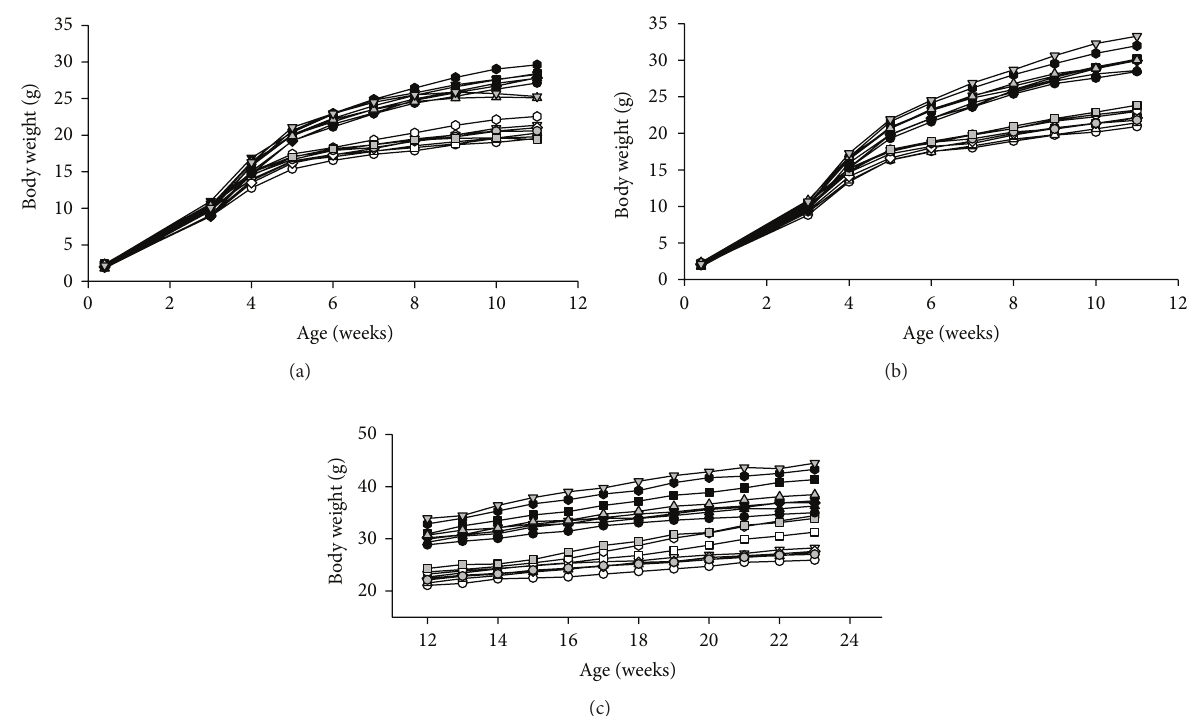
Figure 5: Body weight development (in gram) of female and male mice of all treatment groups is illustrated for (a) Min/+ and (b) wild-type mice from age 3-4 days to 11 weeks, and for (c) wild-type mice from age 12 to 23 weeks. The open white symbols are for untreated female mice; 10+10+10 ( I ), 45+10+10 ( △ ), 10+45+10 ( 󳶚 ), 45+45+10 ( ◻ ), 10+10+45 ( ◊ ), 45+45+45 (open hexagon), and the same filled black symbols are for untreated male mice. The PhIP-treated groups are marked with grey symbols; 45+45+10 PhIP ( I ) and 45+45+45 PhIP ( ◻ ) in females, and 45+45+10 PhIP ( △ ), 45+45+45 PhIP ( 󳶚 ) in males. The experimental groups are as explained in the legend to Figure 1. 𝑛 = 20 – 46